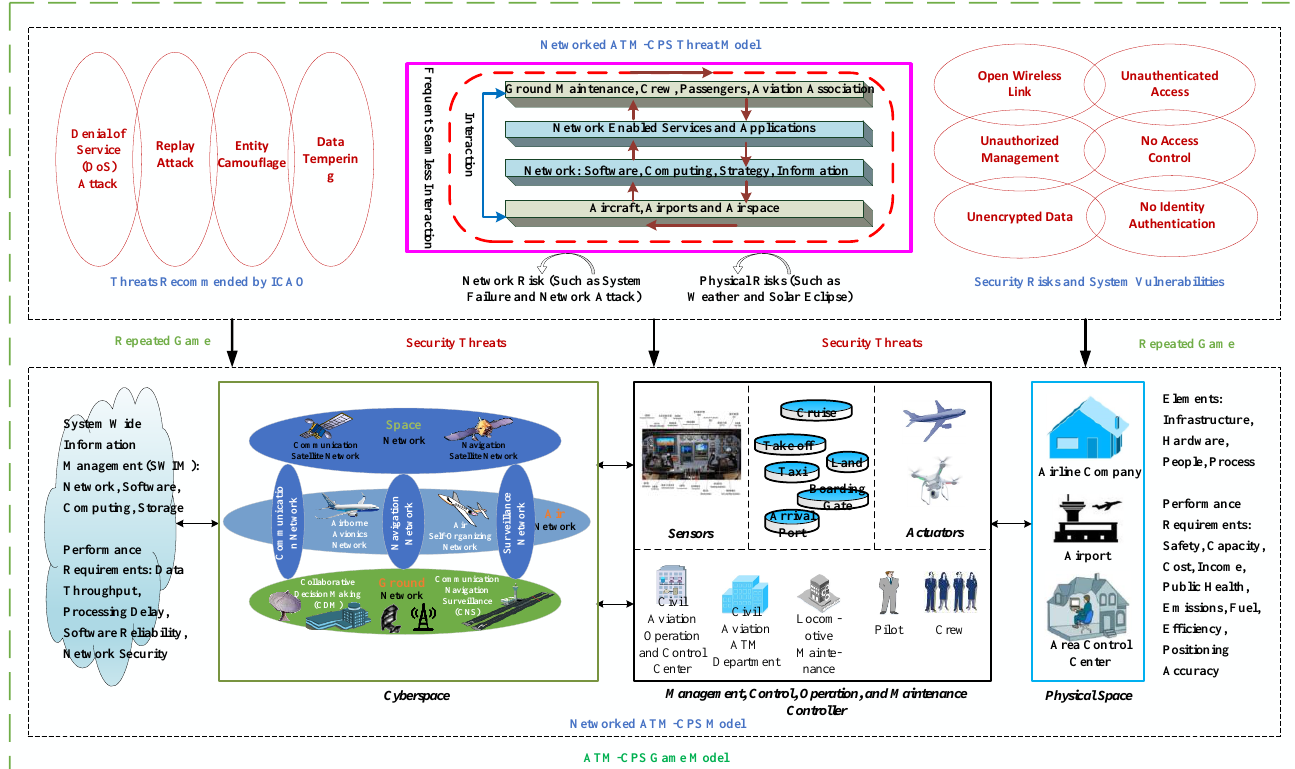
Figure 8. The ATM-CPS game model.